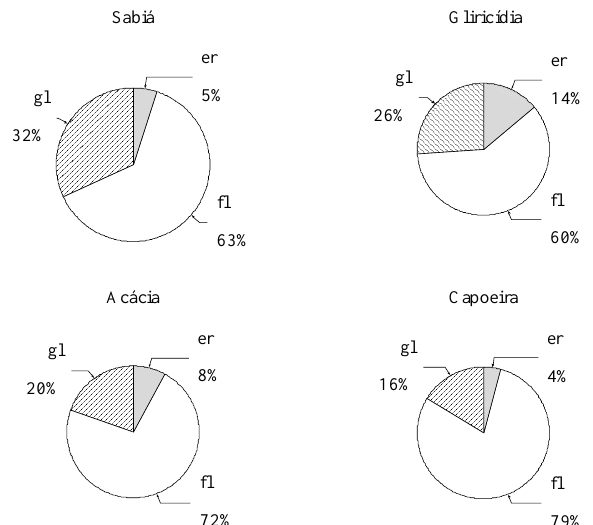
Figura 5. Contribuição relativa dos resíduos da parte área da vegetação que formaram a serapilheira. Identificados como: fl - folhas, gl – galhos e er – estruturas